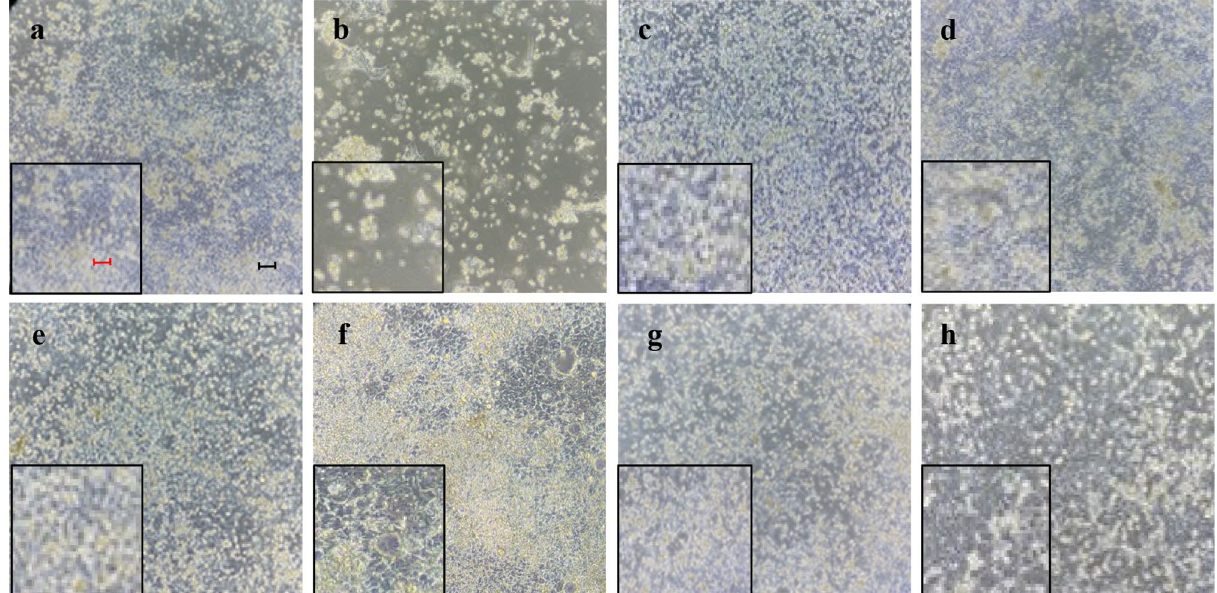
Figure 4. Microscopic observations of Caco-2 cell morphology after: ( a ) 72 h treatment with DMSO vehicle only; ( b ) 72 h pre-treatment with SA and subsequent with DMSO; ( c , d ) 72 h pre-treatment with SA and subsequent with 5 and 50 µM resveratrol respectively; ( e , f ) 72 h pre-treatment with SA and subsequent with 10 and 100 µM pterostilbene, respectively; ( g , h ) 72 h pre-treatment with SA and subsequent with 10 and 100 µM pterostilbene dimer, respectively. The morphology of cells treated with both SA and stilbenoids is similar to the condition of cells shown in (a), treated with DMSO vehicle only. It represents a homogeneous and compact cellular carpet very different from what is shown in (b). Every picture reports a 5 × magnification on the left for a better image evaluation. Black bar represents 10 µm, the red one, 50 µm.